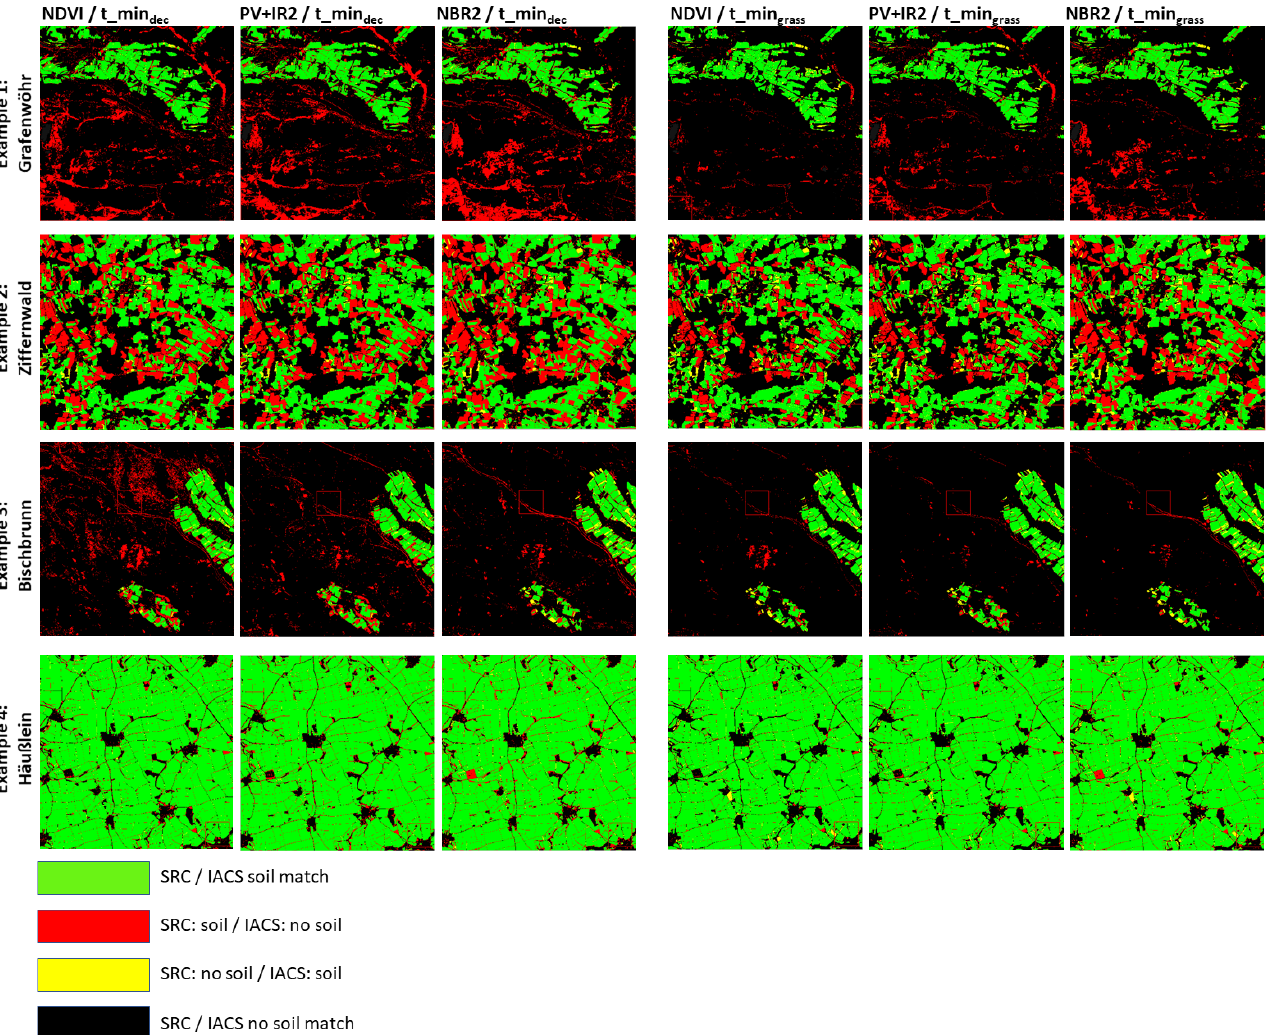
Figure 10. Selective example cases for the spatial agreement between the SRC and IACS bare soil